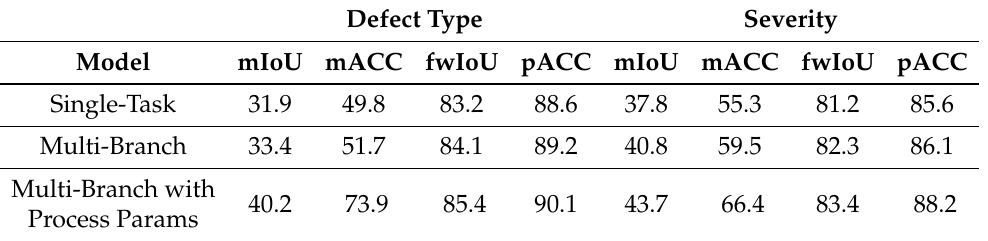
Figure 9. Confusion matrices for the severity segmentation network (validation set). The first chart shows the confusion matrix for the foreground pixels. Severity level 3 has the highest accuracy, with some confusion with level 2 defects. Severity 1 and 2 clearly show confusion with the other severity levels, especially severity 1, which are mostly segmented as level 2 defects. The second chart shows the background/foreground confusion matrix. Here, we can see that this network performed better on the back- and foreground task than the defect type network shown in Figure 8. Table 1. This table summarizes the performance metrics of the single-task, multi-branch, and multi- branch model extended with process parameters on the validation set. The table shows the following metrics: mean IoU, mean accuracy, frequency weighted IoU, and pixel accuracy. For both tasks, the performance increased when combining the two tasks into one multi-task model (second row). Moreover, after extending the multi-branch model with process parameters, the performance of both tasks increased significantly (third